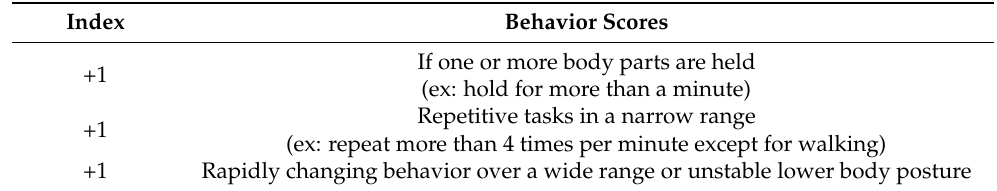
Table 15. Static/repetitive behavior scores.